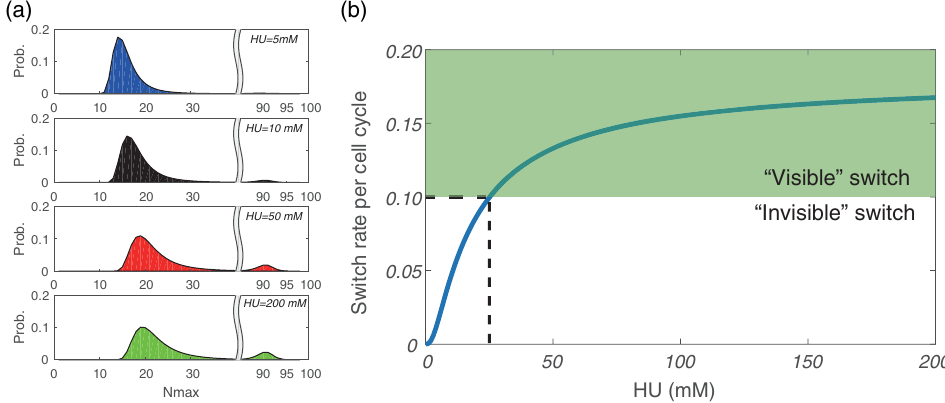
FIG. 10. Threshold effect of HU doses in the off-on switch of autophosphorylation site mutant strains. (a) Probability distribution of N t ¼ 70 min Þ (maximum within 70 min) under different HU doses. The bimodal distribution can hardly be observed for HU ¼ 5 - m ð mM and 10-mM doses. (b) Off-on switch rate under different HU doses. X label: concentration of HU stimulation. Y label: switch rate per cell cycle (taking 100 min, for simplicity). The threshold of the switch rate is chosen such that 10% of the cells can be activated during the cell